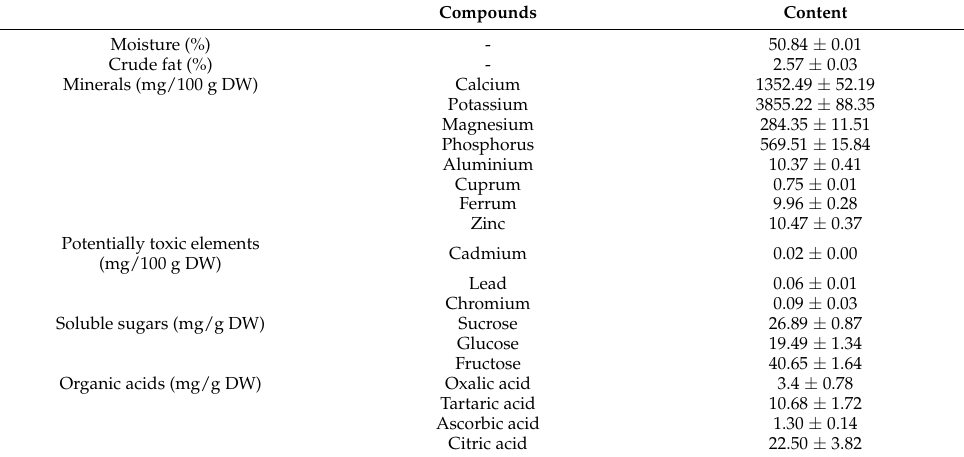
Table 1. The contents of moisture, crude fat, mineral elements, soluble sugars, and organic acids in Gonostegia hirta